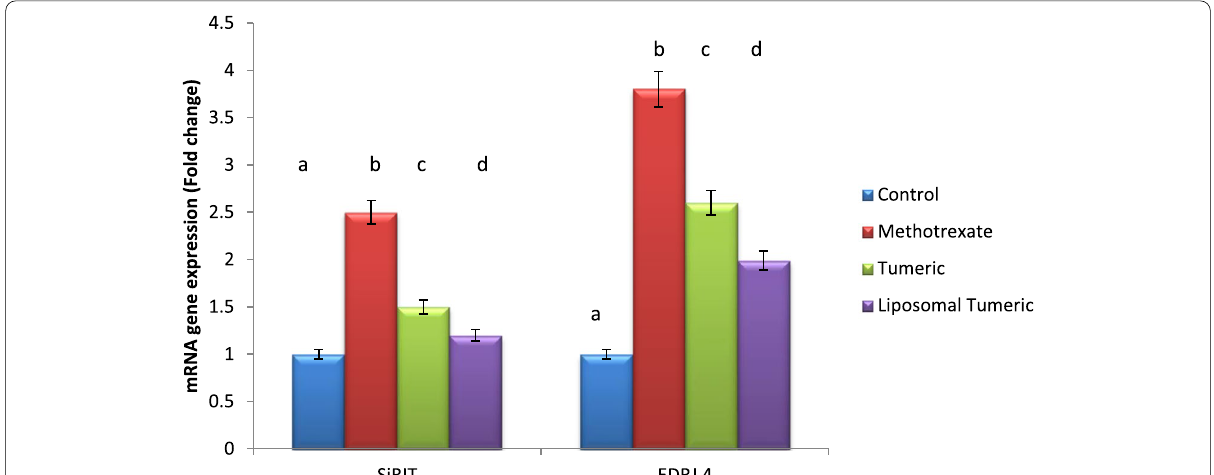
Fig. 3 Impact of turmeric and liposomal turmeric on serum autophagy markers SiRT-1 and ERDJ-4 gene expression post methotrexate intoxication. GAPDH was used as an internal control for calculating mRNA fold changes. Data are expressed as mean considered significant. Groups having the same letter are not significantly different from each other, while those having different letters are significantly different from each